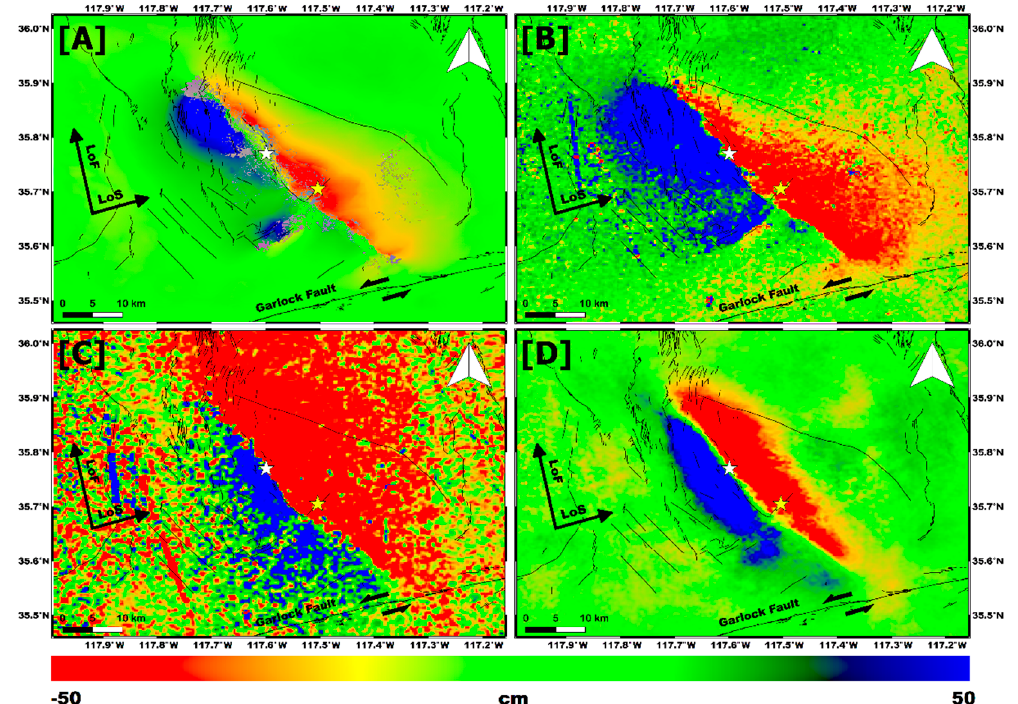
Figure 2. LOS InSAR ( A) and POT ( B) displacement maps and LOF (or azimuth) POT (C) and MAI (D) displacement maps. The yellow and white stars indicate the respective epicenters of the Mw 6.4 and Mw 7.1 earthquakes of the 2019 Ridgecrest sequence. For LOS displacement ( A , B ), blue color (positive values) indicates a movement toward the satellite and vice versa for red (negative values). For LOF displacement ( C , D ), blue color (positive values) indicates a movement consistent with the satellite orbit direction.